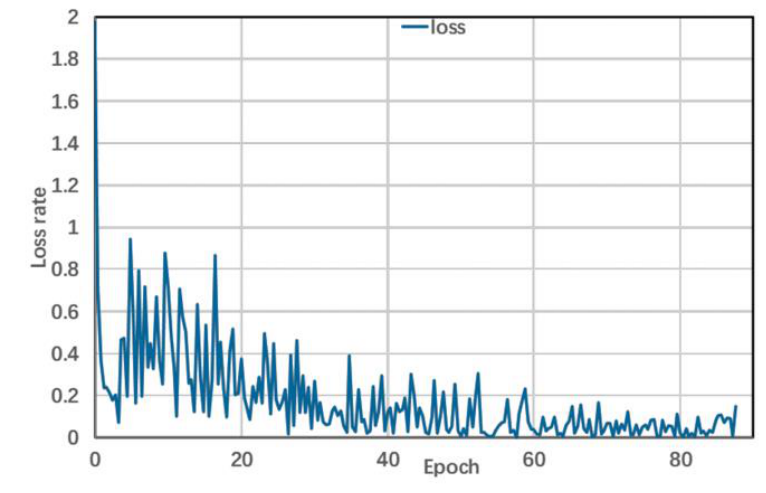
Figure 7. Variation of model loss with the number of epochs.